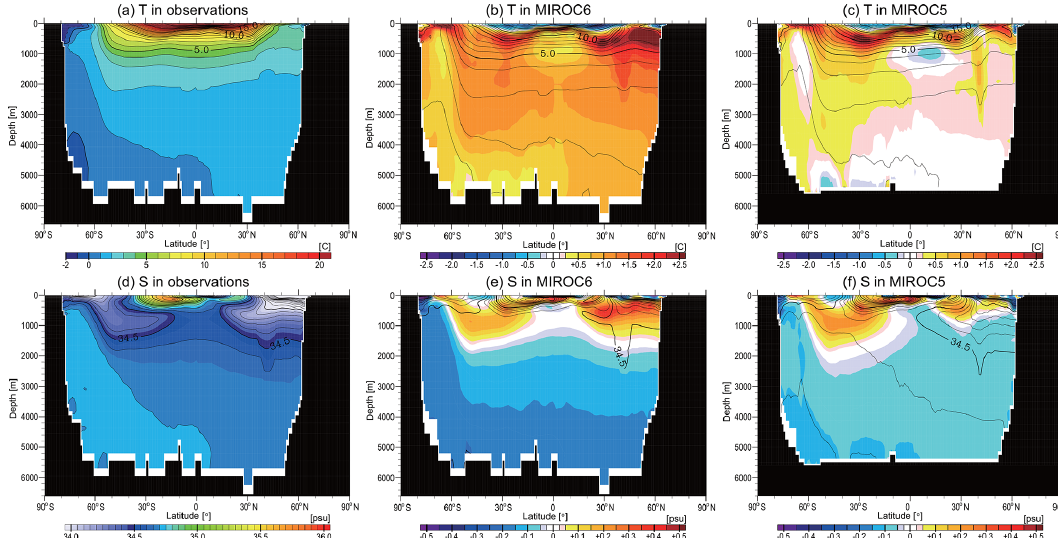
Figure 14. Same as Fig. 13, but for the Pacific